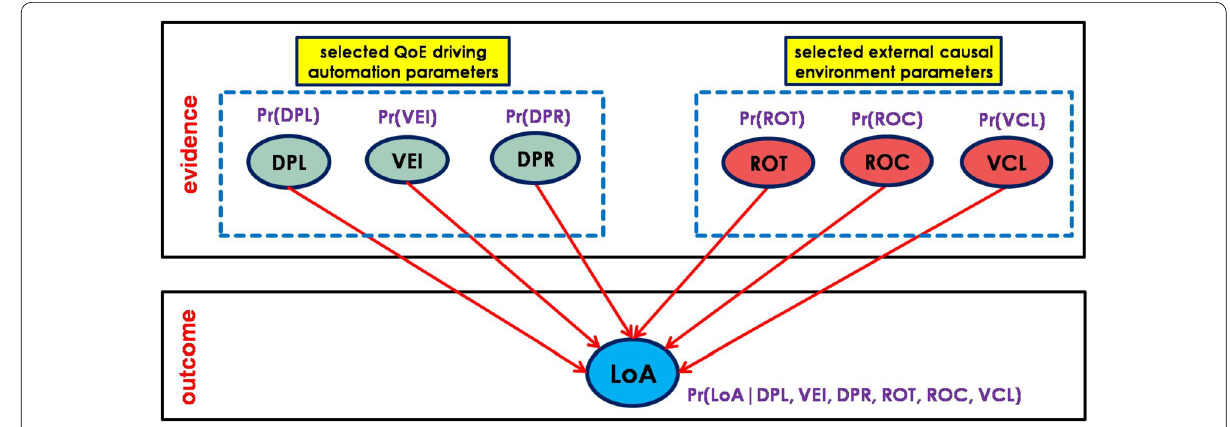
Figure 3 Proposed learning causal Bayesian